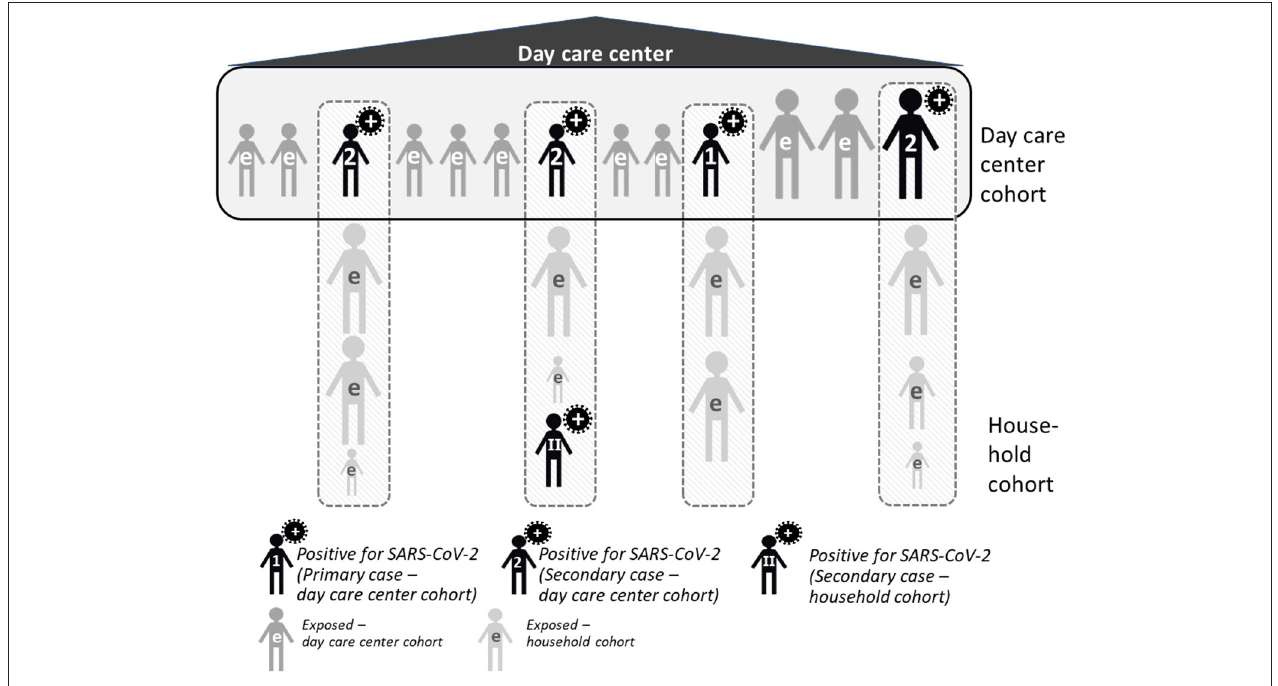
FIGURE 1 | Study design of COALA. e,